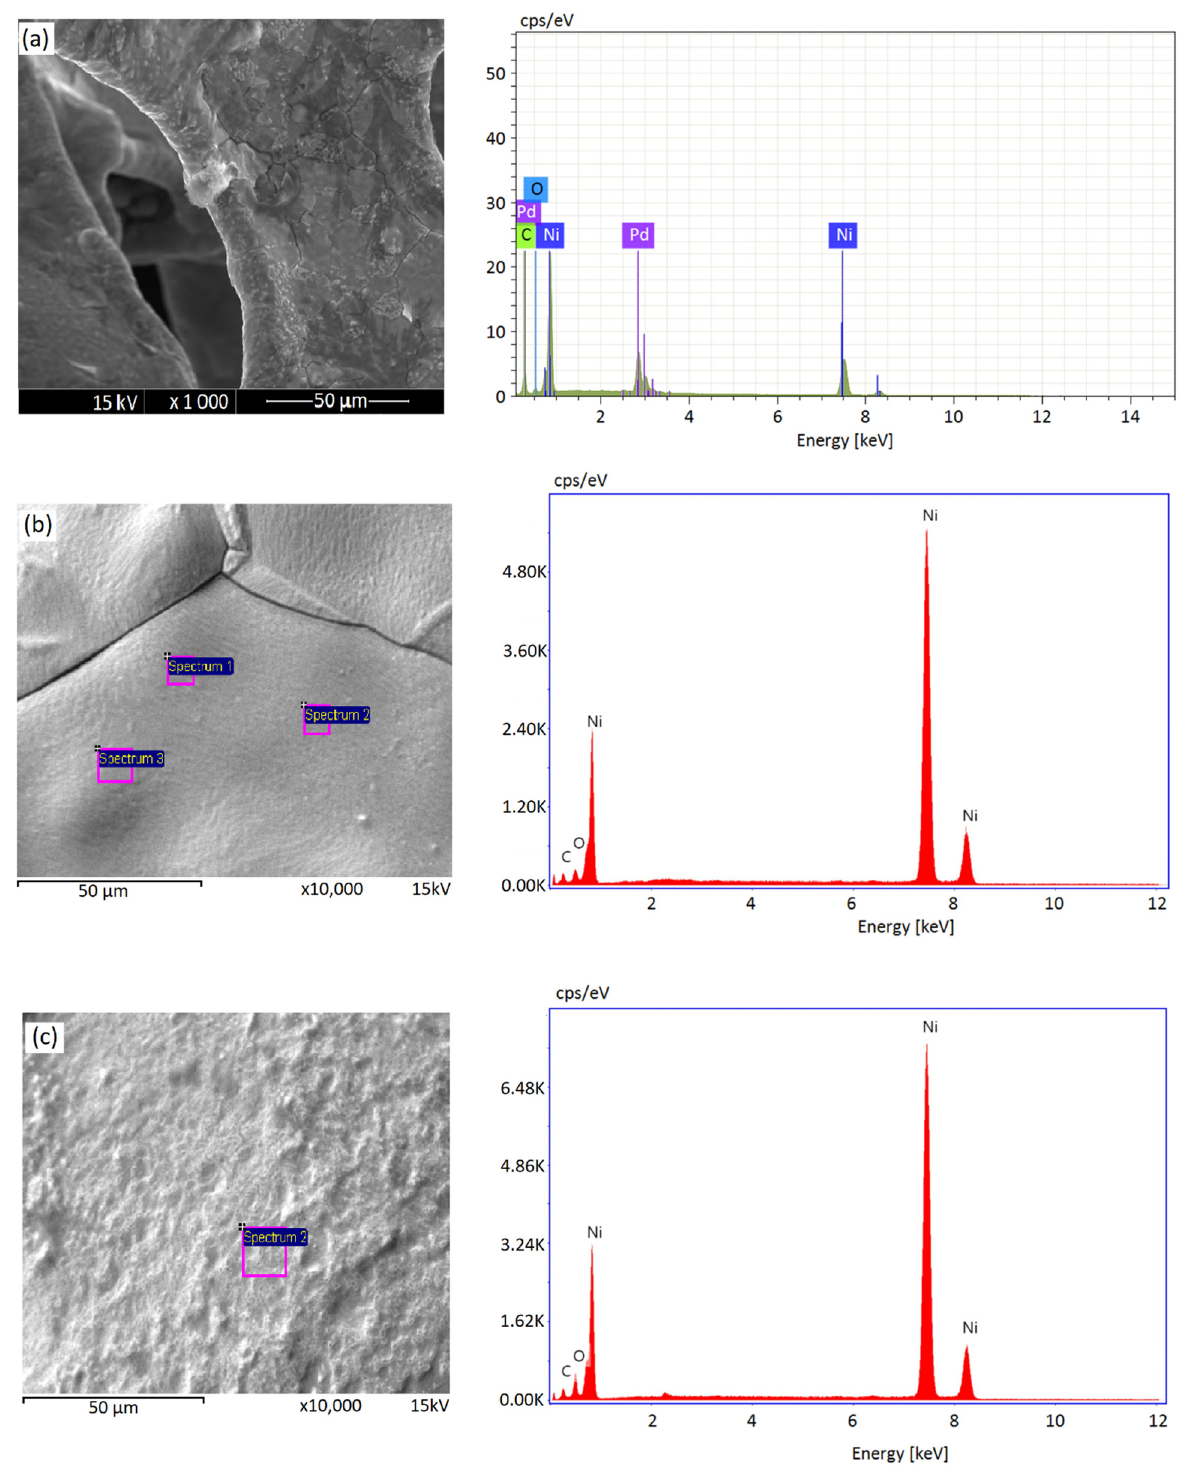
Figure 4. ( a ) SEM micrograph picture (recorded at 1000 × magnification) and EDX spectrogram for Pd-activated Ni foam (sample 1, ca. 0.19 wt.% Pd). ( b , c ) SEM micrograph pictures (recorded at 10,000 × magnification) and EDX spectrograms for unmodified and electro-oxidised Ni foam samples, correspondingly (Quanta FEG 250 SEM with Bruker XFlash 5010 EDX supplement were employed).